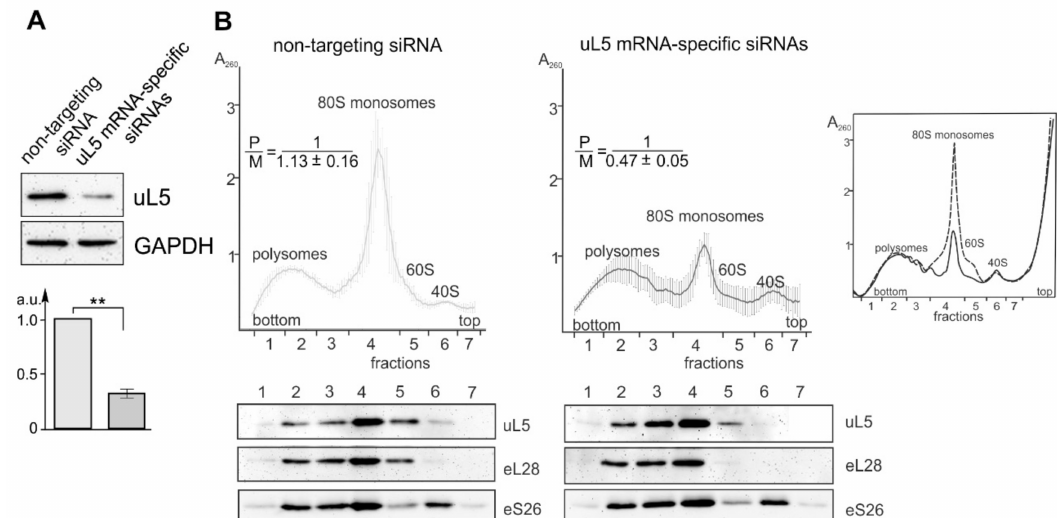
Figure 1. The characterization of HEK293T cells knocked down of ribosomal protein uL5. ( A ) Western blot analysis of the levels of uL5 and GAPDH (as a reference) in cells transfected with uL5-specific siRNAs and non-targeting siRNA. The diagram shows triplicate data as the mean of arbitrary units (A.U.) ± SEM (** p < 0.01, calculated using a Mann–Whitney test). ( B ) Polysome profiles obtained by the sucrose density gradient centrifugation of the lysates of cells transfected with non-targeting siRNA (left) and uL5 mRNA-specific siRNAs (middle). The peaks of 60S and 40S subunitsand 80S monosomes and polysomes are marked. The averaged polysome profiles are derived from flow cell measurements and shown as curves drawn through 100 points with error bars, which correspond to the average absorbance at 260 nm ± SD of 4 replicates. P/M means the ratio between the peaks of polysomes and 80S monosomes calculated from 4 replicates. Below each profile, data from the Western blot analysis of the sucrose gradient fractions for the presence of uL5 and ribosomal proteins eL28 and eS26 (as references) carried out using specific antibodies are presented. A superposition of polysome profiles obtained from uL5 knocked down cells (solid line) and cells treated with non-targeting siRNA (dashed line) is shown for one of the replicates of each cell sample in a separate box on the